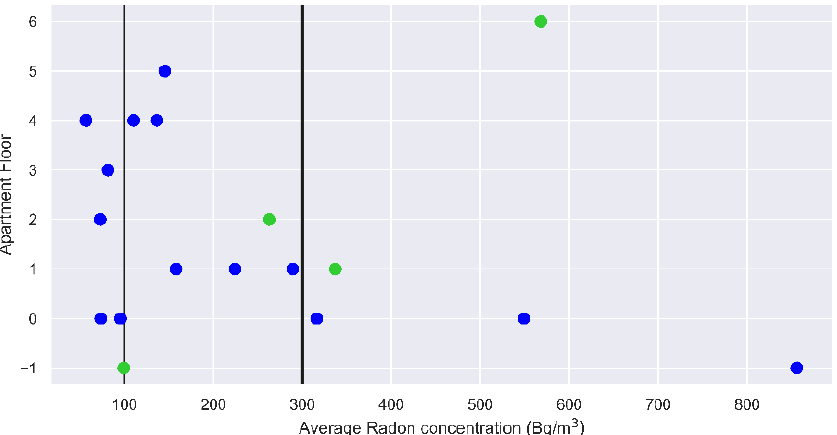
Figure 5. Average radon concentration versus the apartment floor (when this piece of information is available). Green circles refer to apartments in buildings located in Rome’s historical center, built between 1870 and 1900. Black vertical lines mark the reference levels recommended by EURATOM (thick) and WHO (thin).